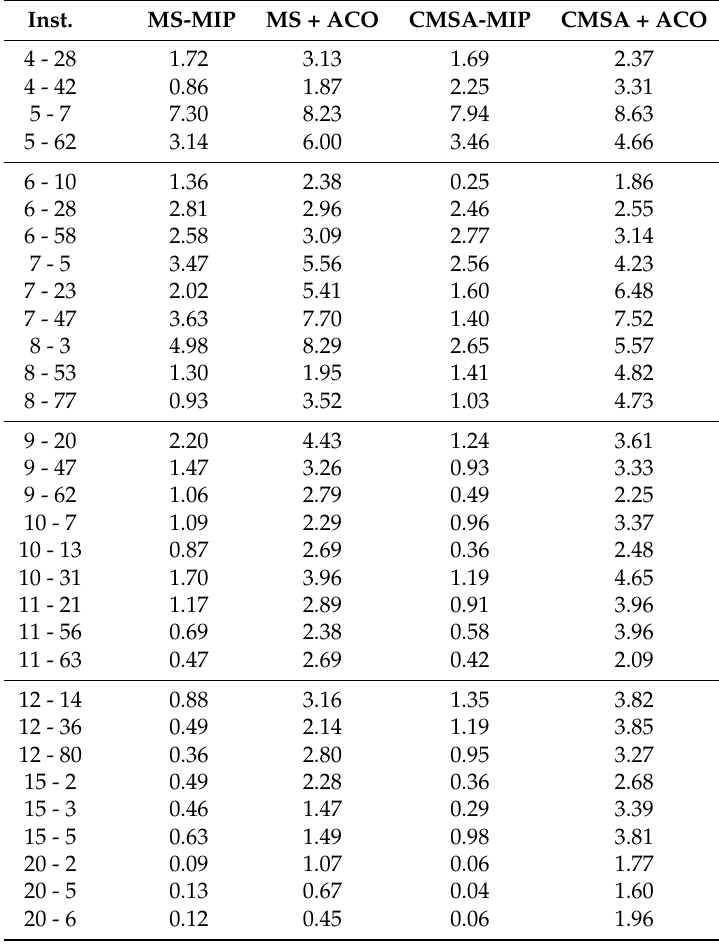
Table 4. The contribution of the merge step of MS-ACO and CMSA-ACO, relative to the total solution improvement. The MIP results sum up the percentage improvement in the objective for every MIP solve for an instance. The MS/CMSA+ACO result is the percentage difference of the first best solution found to the best solution at the end of the run. Small instances where the best solution is the first one found have been omitted. Inst. MS-MIP MS + ACO CMSA-MIP CMSA +